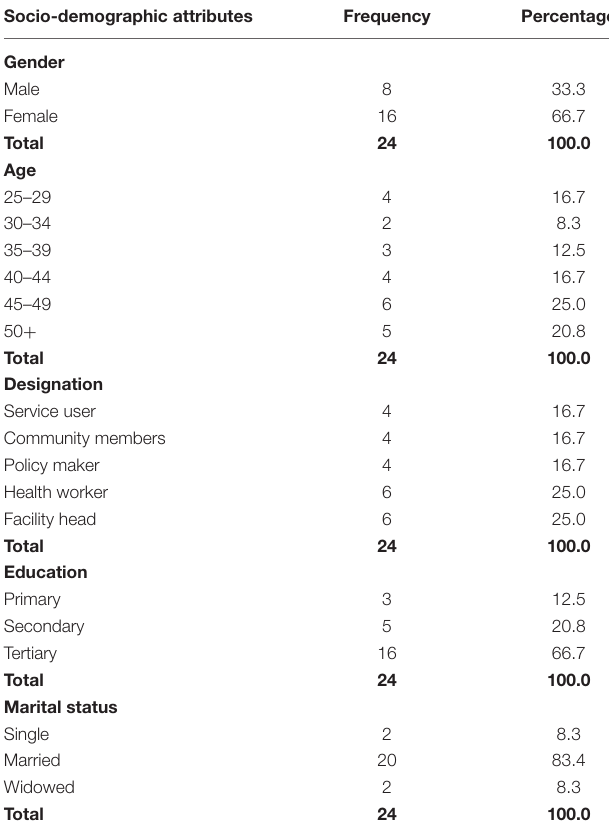
TABLE 3 | Characteristics of stakeholders interviewed for legacy